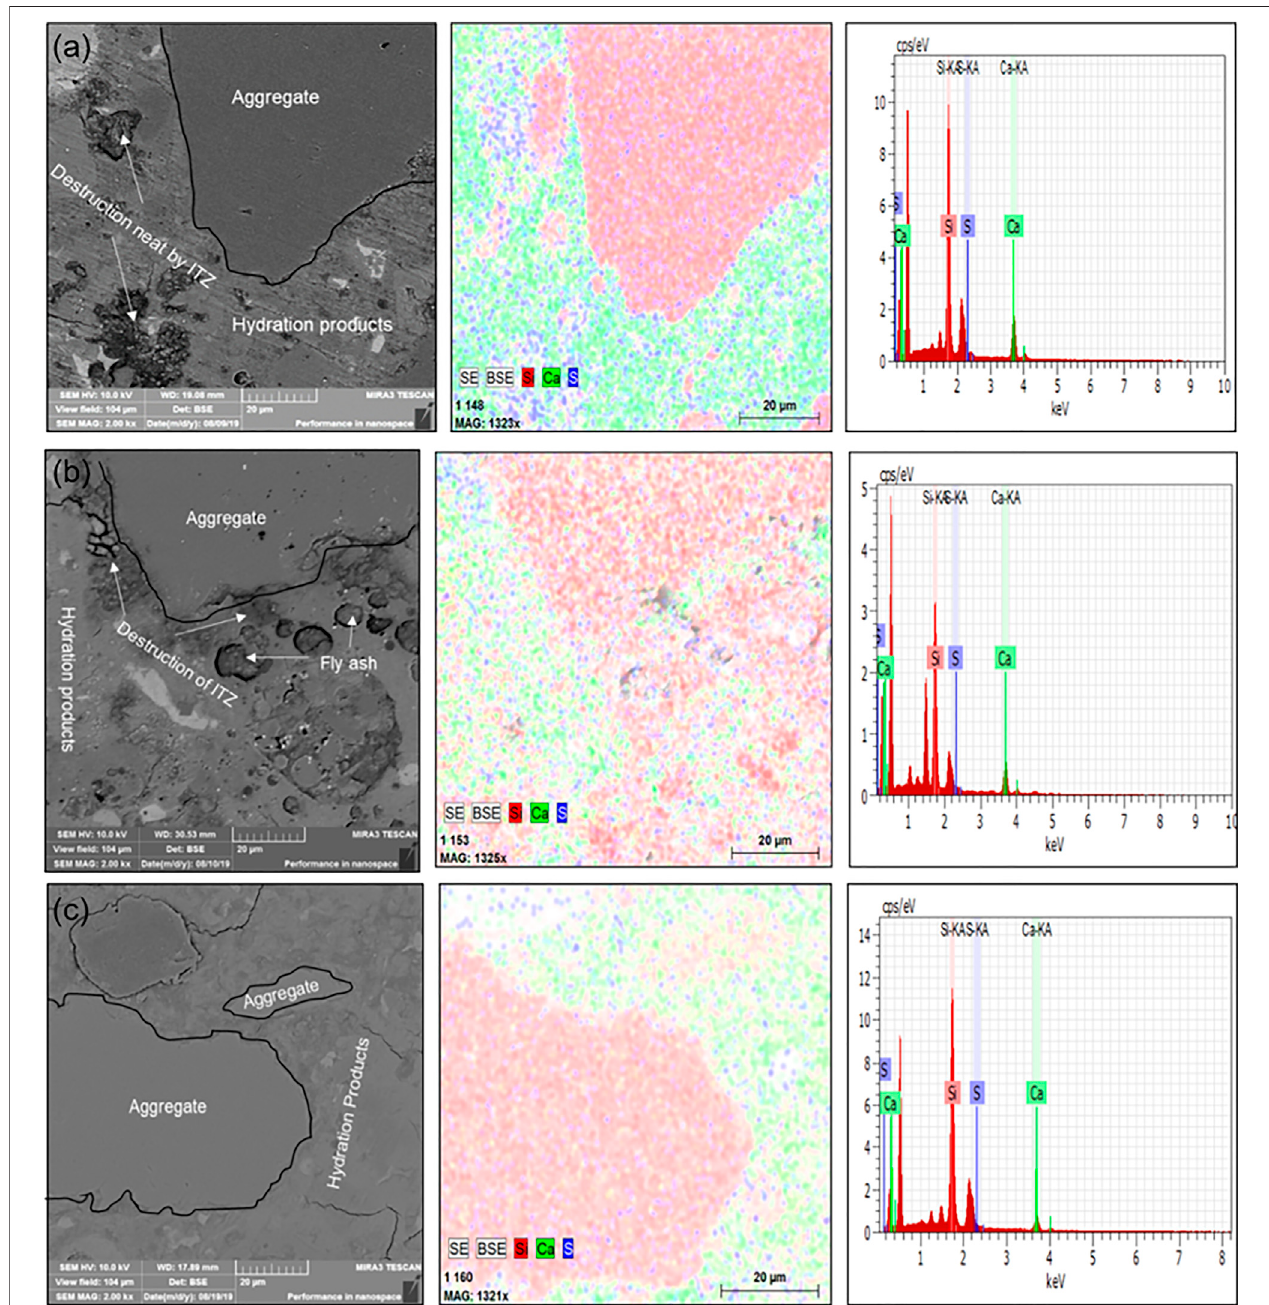
FIGURE 9 | BSE images with EDX color mapping of fl y ash concrete specimens (A) 30FA sample (B) 30FA3SNPs sample (C) 30FA6SF sample after exposed in sulphate attack after 365 days of exposure.